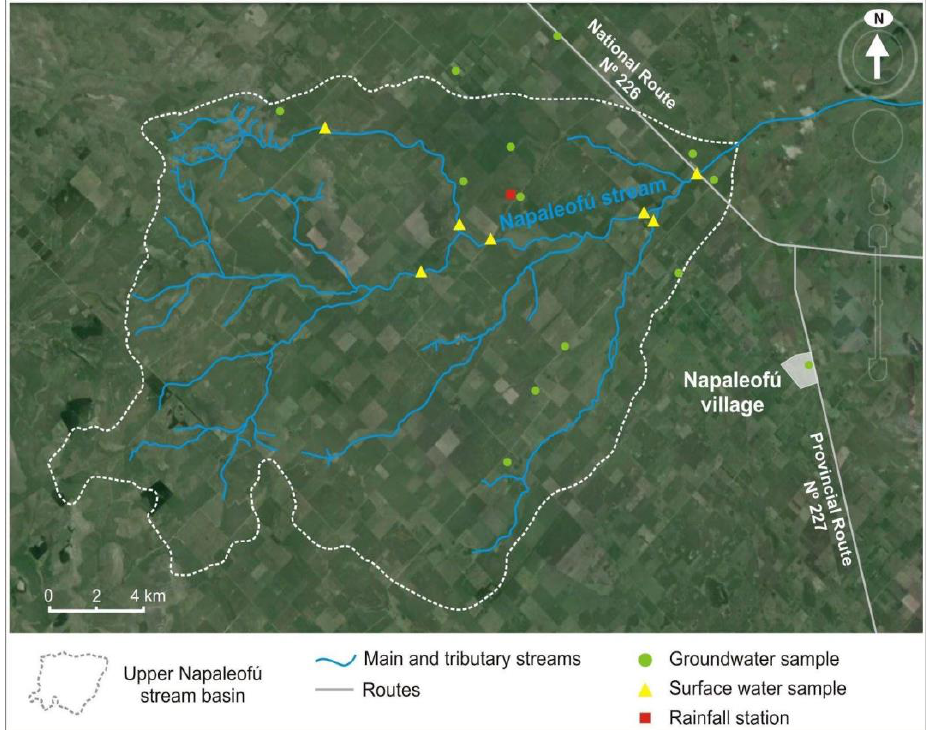
Figure 3. Location of the Napaleofú stream, groundwater, and surface water sampling points and rainfall station.